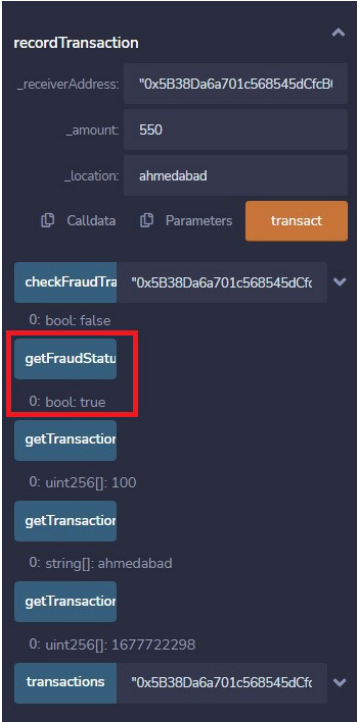
Figure 10. Fraud transaction SC